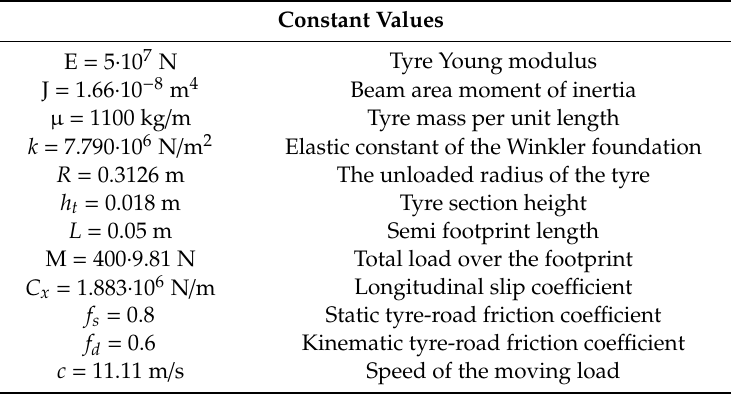
Table 2. List of the constant values (see the Reference [8] for more